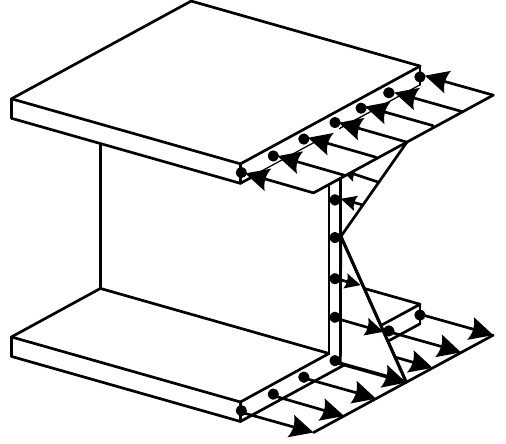
Figure 1. Loading Condition; End